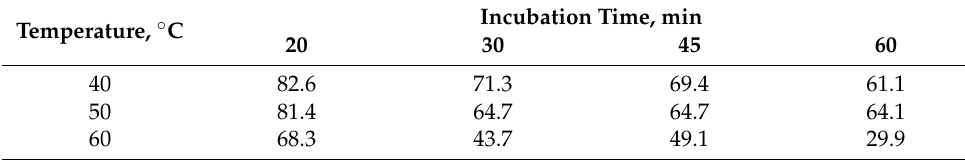
Table 2. Thermal stability of MDH-His 6 -tag measured by residual activity,